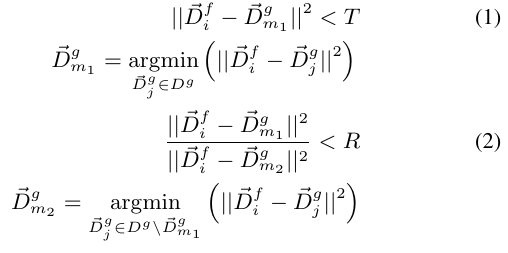
Figure 2: Flowchart of the